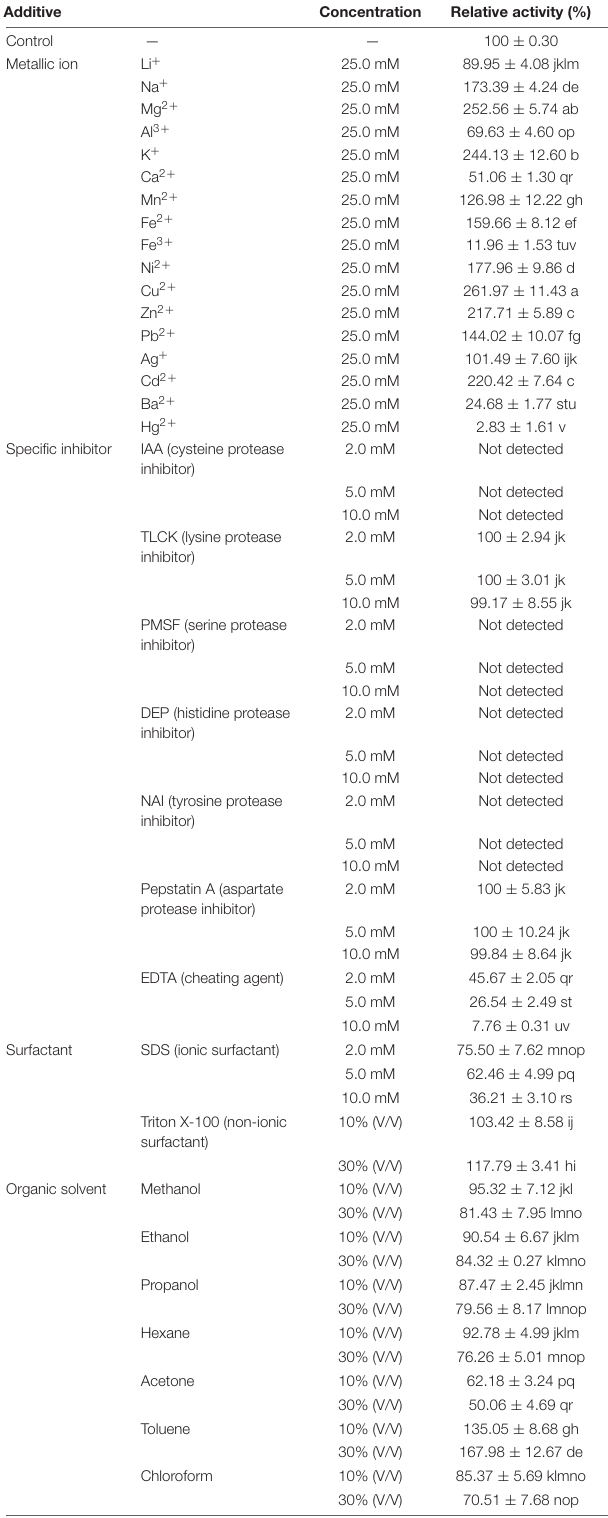
TABLE 2 | Effect of metallic ions, specific inhibitors, surfactants, and organic solvents on activity of laccase ThLacc-S from Trametes hirsuta